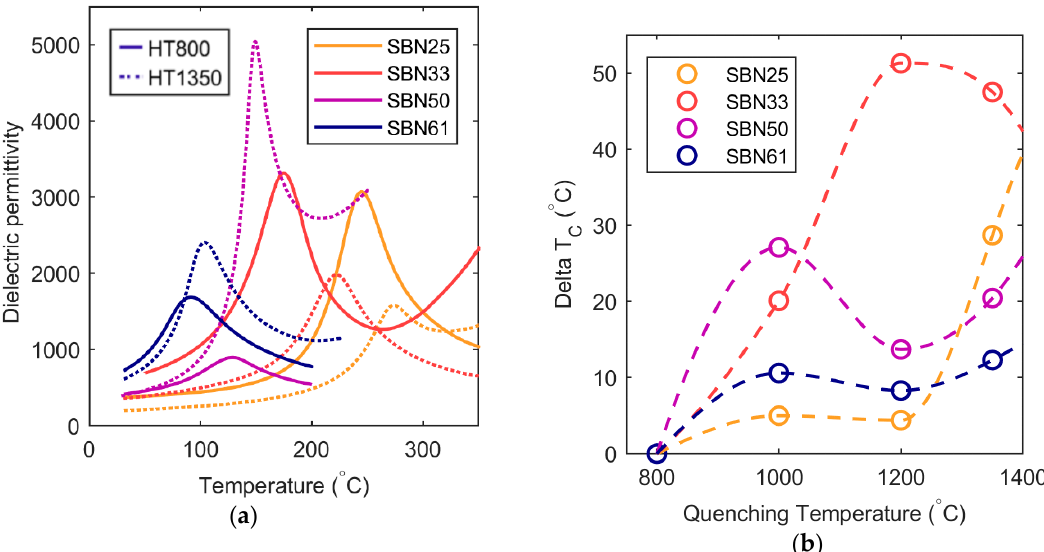
Figure 2. ( a ) Selected permittivity curves for all the compositions and two heat treatment (HT) temperatures. Note that SBN33 heat treated at 1350 °C have been reoxidized. ( b ) Change in critical temperature (T C –T C, 800 °C ) as a function of quenching temperature.